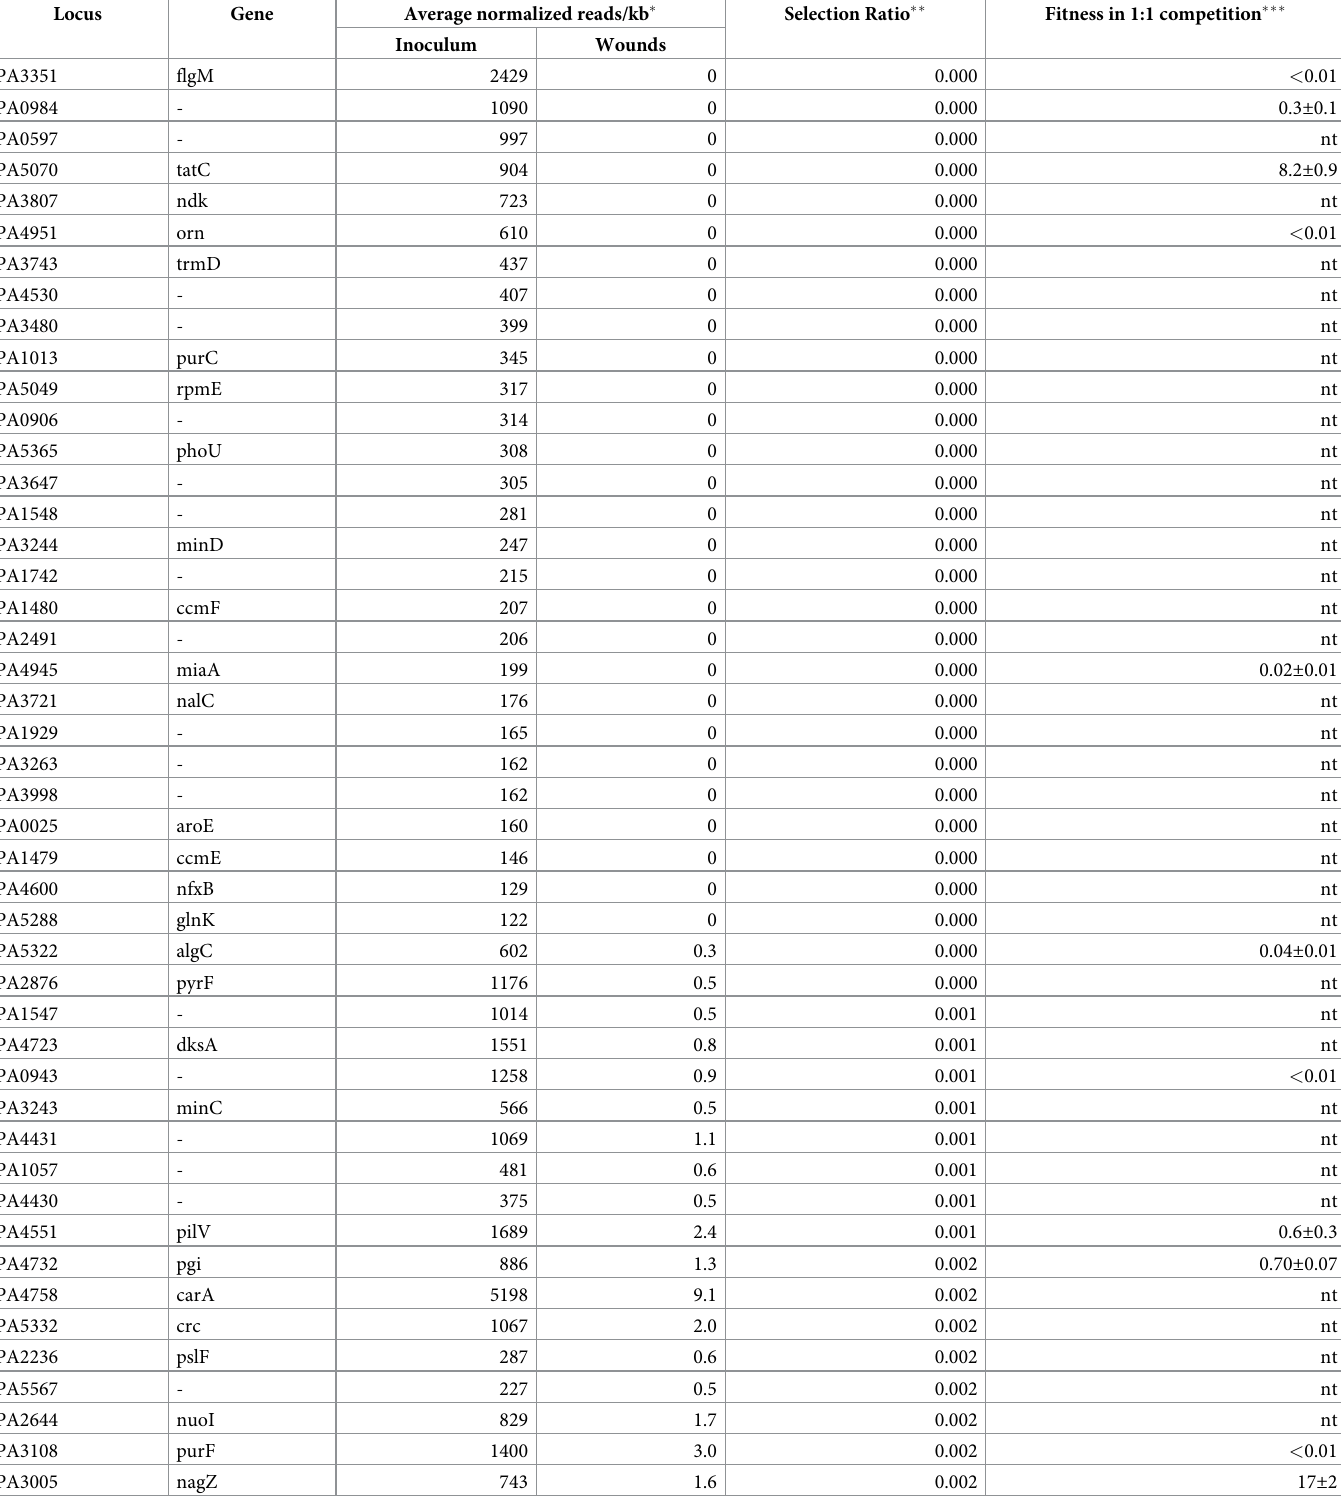
Table 2. Genes with decreased representation following Tn-seq indicating a possible role of these genes in fitness in the chronic wound infection.